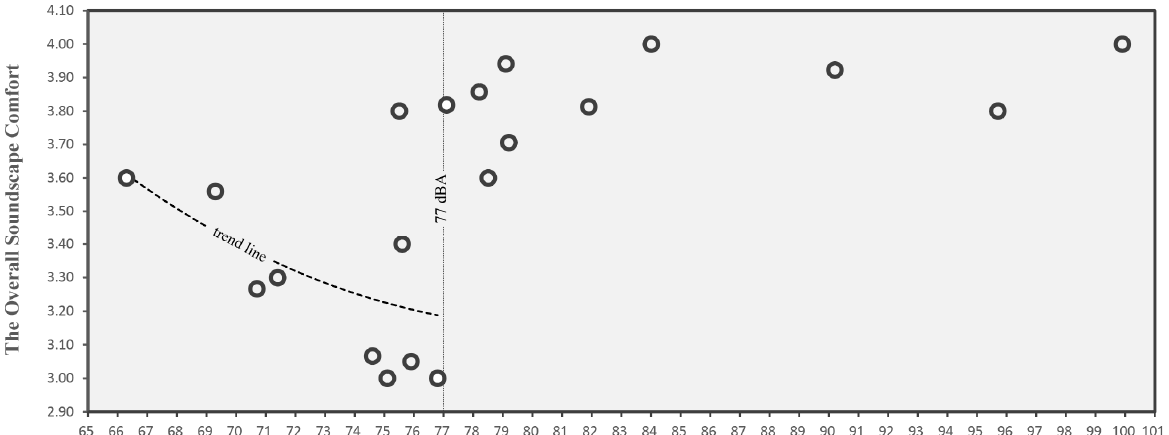
Figure 3. Scatter plot showing the relation between the overall soundscape comfort and sound pres- sure level.